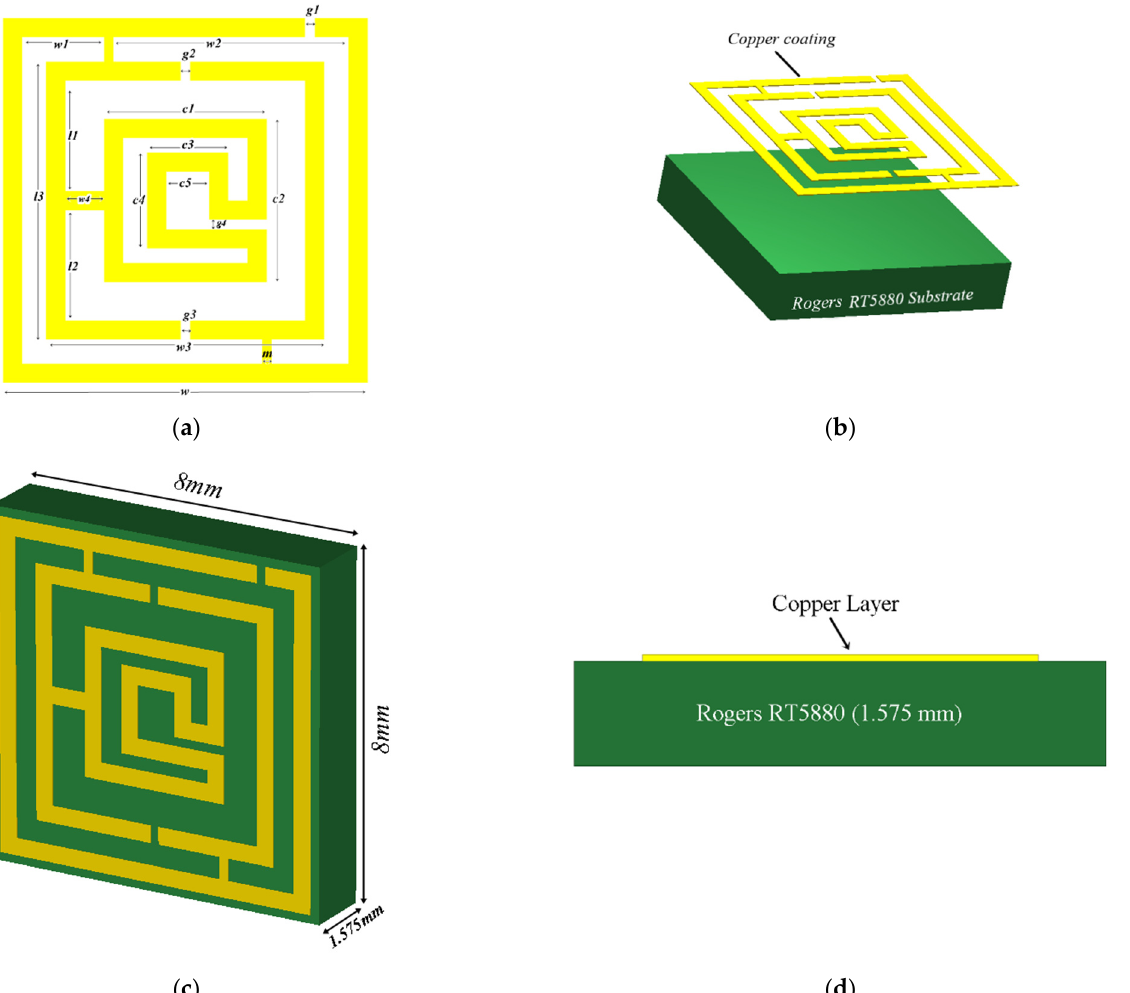
Figure 1. ( a ) Unit cell design parameters and ( b – d ) schematic and 3D structure of the proposed metamaterial unit cell.